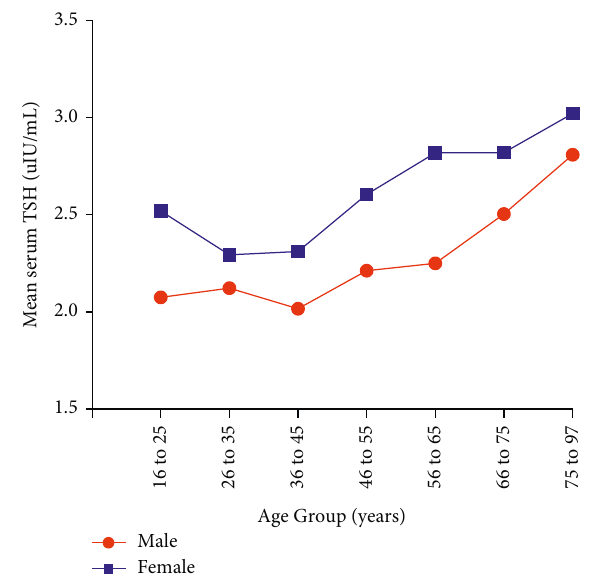
Figure 4: Mean serum TSH in different age subgroups. TSH, �